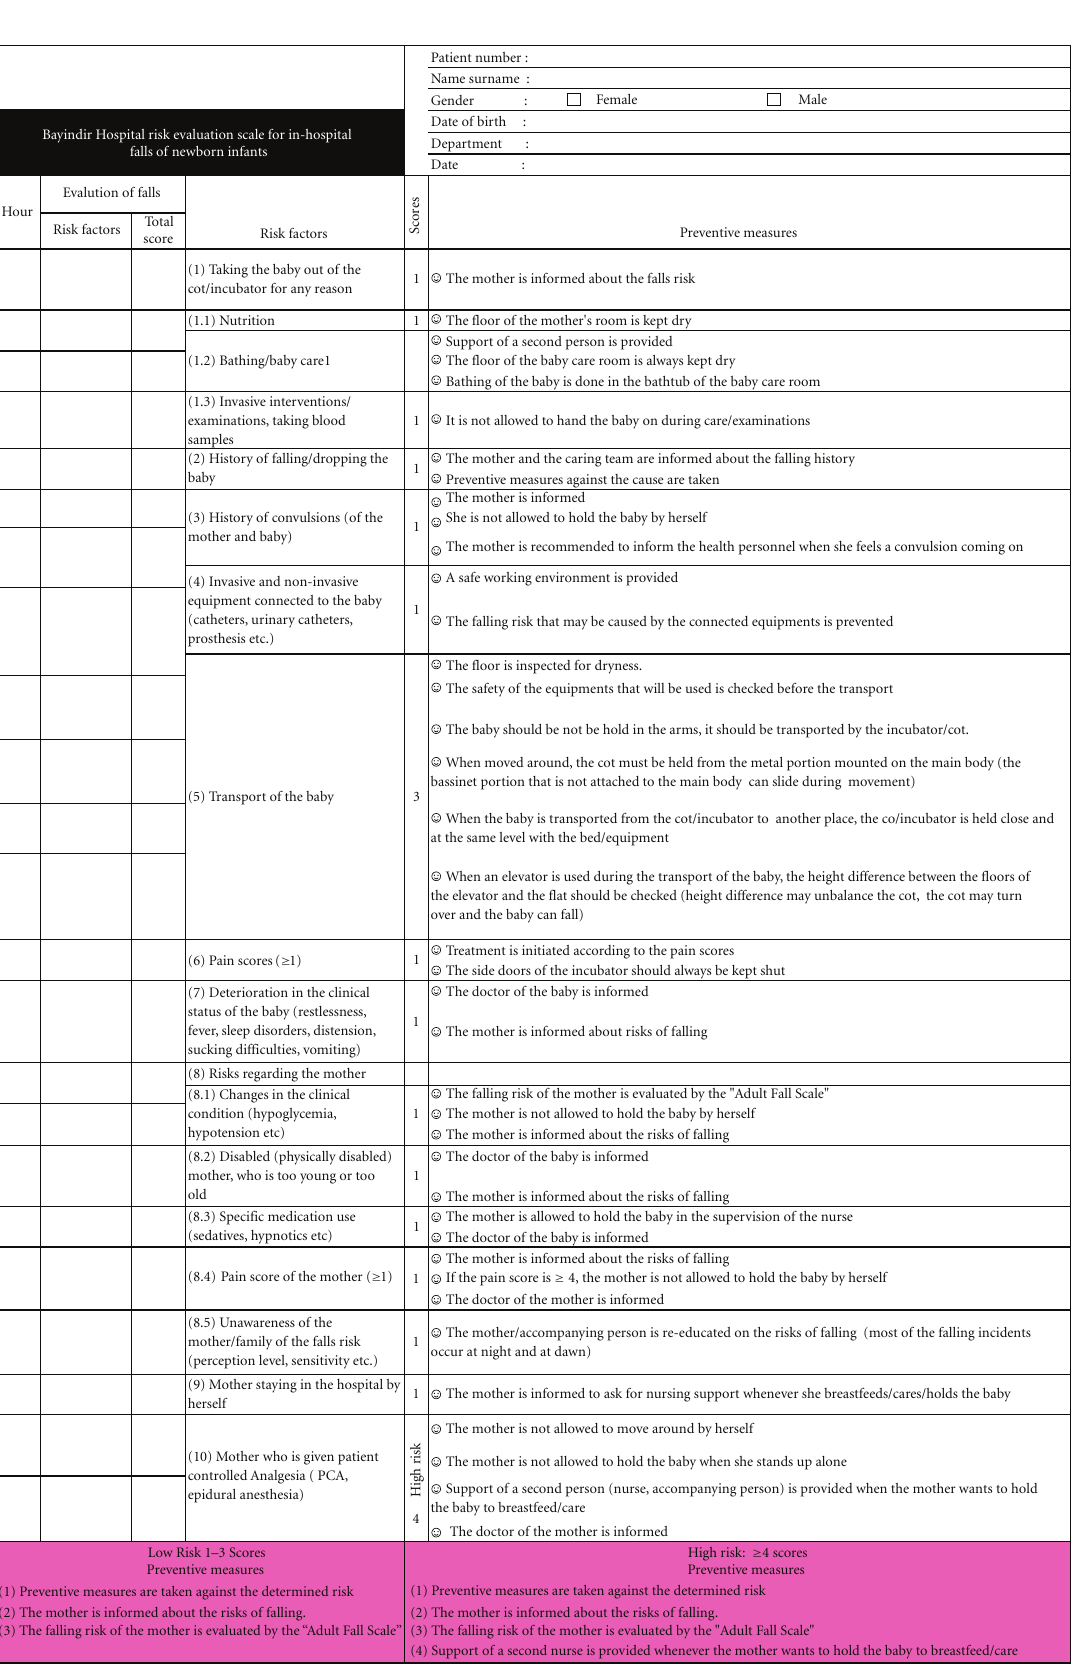
Figure 1: Bayındır Hospital risk evaluation scale for in-hospital falls of newborn